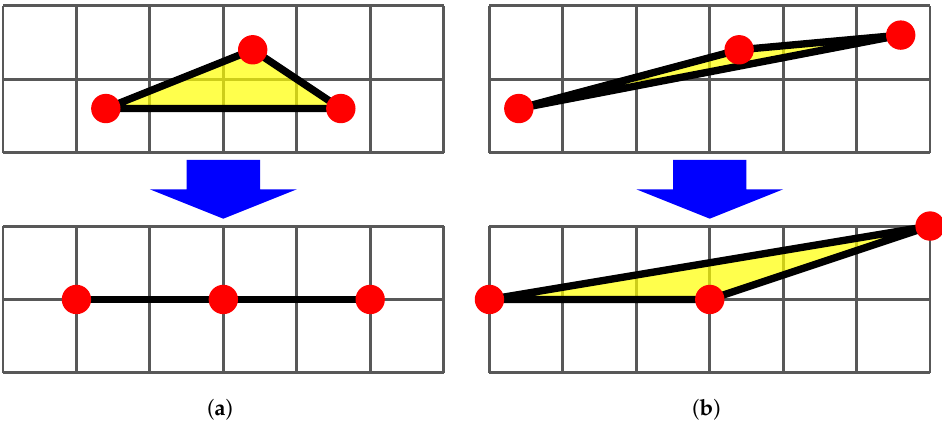
Figure 4. Changes due to the usage of integer coordinates instead of floating. ( a ) Degeneration. ( b ) Orientation.